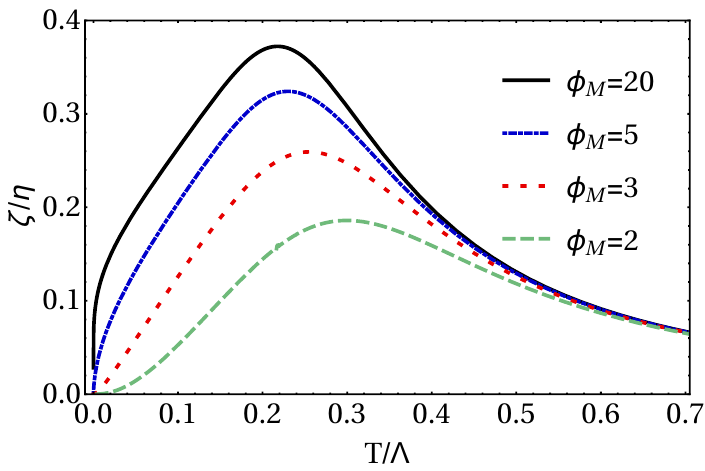
Figure 3 . Bulk viscosity (cid:16) over shear viscosity (cid:17) as a function of temperature for (cid:30) M = f 20 ; 5 ; 3 ; 2 g . For each (cid:30) we obtain max( (cid:16)=(cid:17) ) = f 0 : 19 ; 0 : 26 ; 0 : 32 ; 0 : 37 g at the respective temperatures M T= (cid:3) = f 0 : 218 ; 0 : 220 ; 0 : 230 ; 0 : 299 g